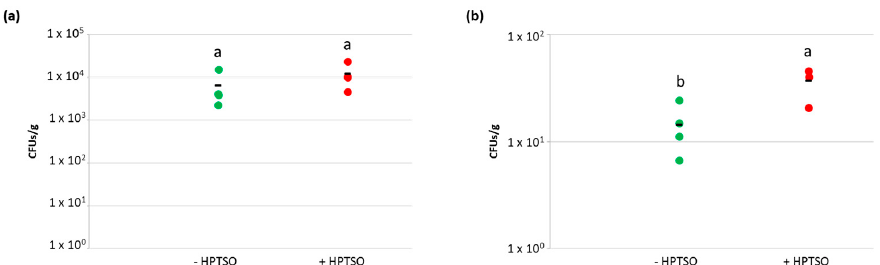
Figure 5. Entry and survival of culturable A. baylyi BD413 cells in lettuce endosphere. Number of total ( a ) and transformant ( b ) A. baylyi BD413 CFUs/g of leaf reisolated from lettuce endosphere in presence (+HPTSO) or absence (-HPTSO) of the surfactant molecule heptamethyltrisiloxane. The black line indicates the average value of four biological replicates. In each panel, different letters (a, b) indicate significant differences of the CFUs/g of A. baylyi BD413 detected in the presence/absence of HPTSO, according to Student’s t -test ( p -value > 0.05).